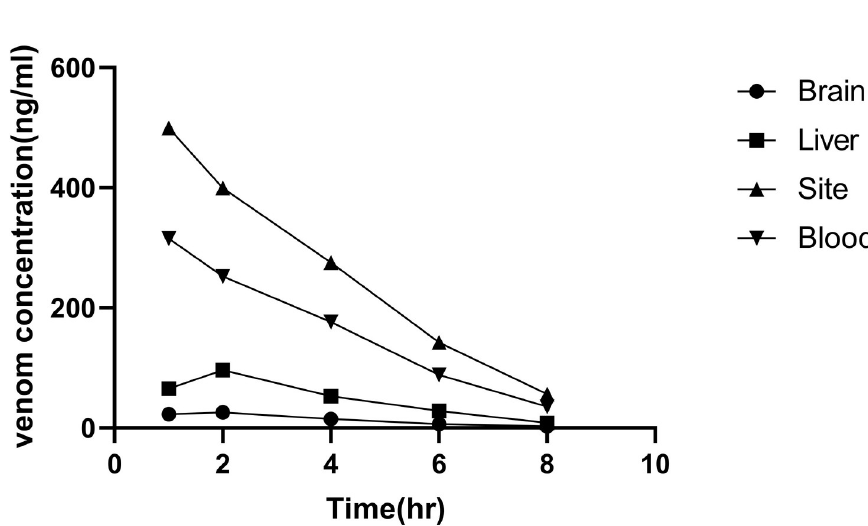
Fig 8. Kinetics of the BM venom injected in rats (simulated amount of snake venom at a snakebite dose in human): Crude BM venom in normal saline (200 μ l) was injected subcutaneously to the back leg of the rats. The supernatants of tissue samples and serum were collected at five time points (1, 2, 4, 6, and 8 h) post injection. Data are presented herein as mean ± SD from six rats in each group. All samples were analyzed in triplicate.